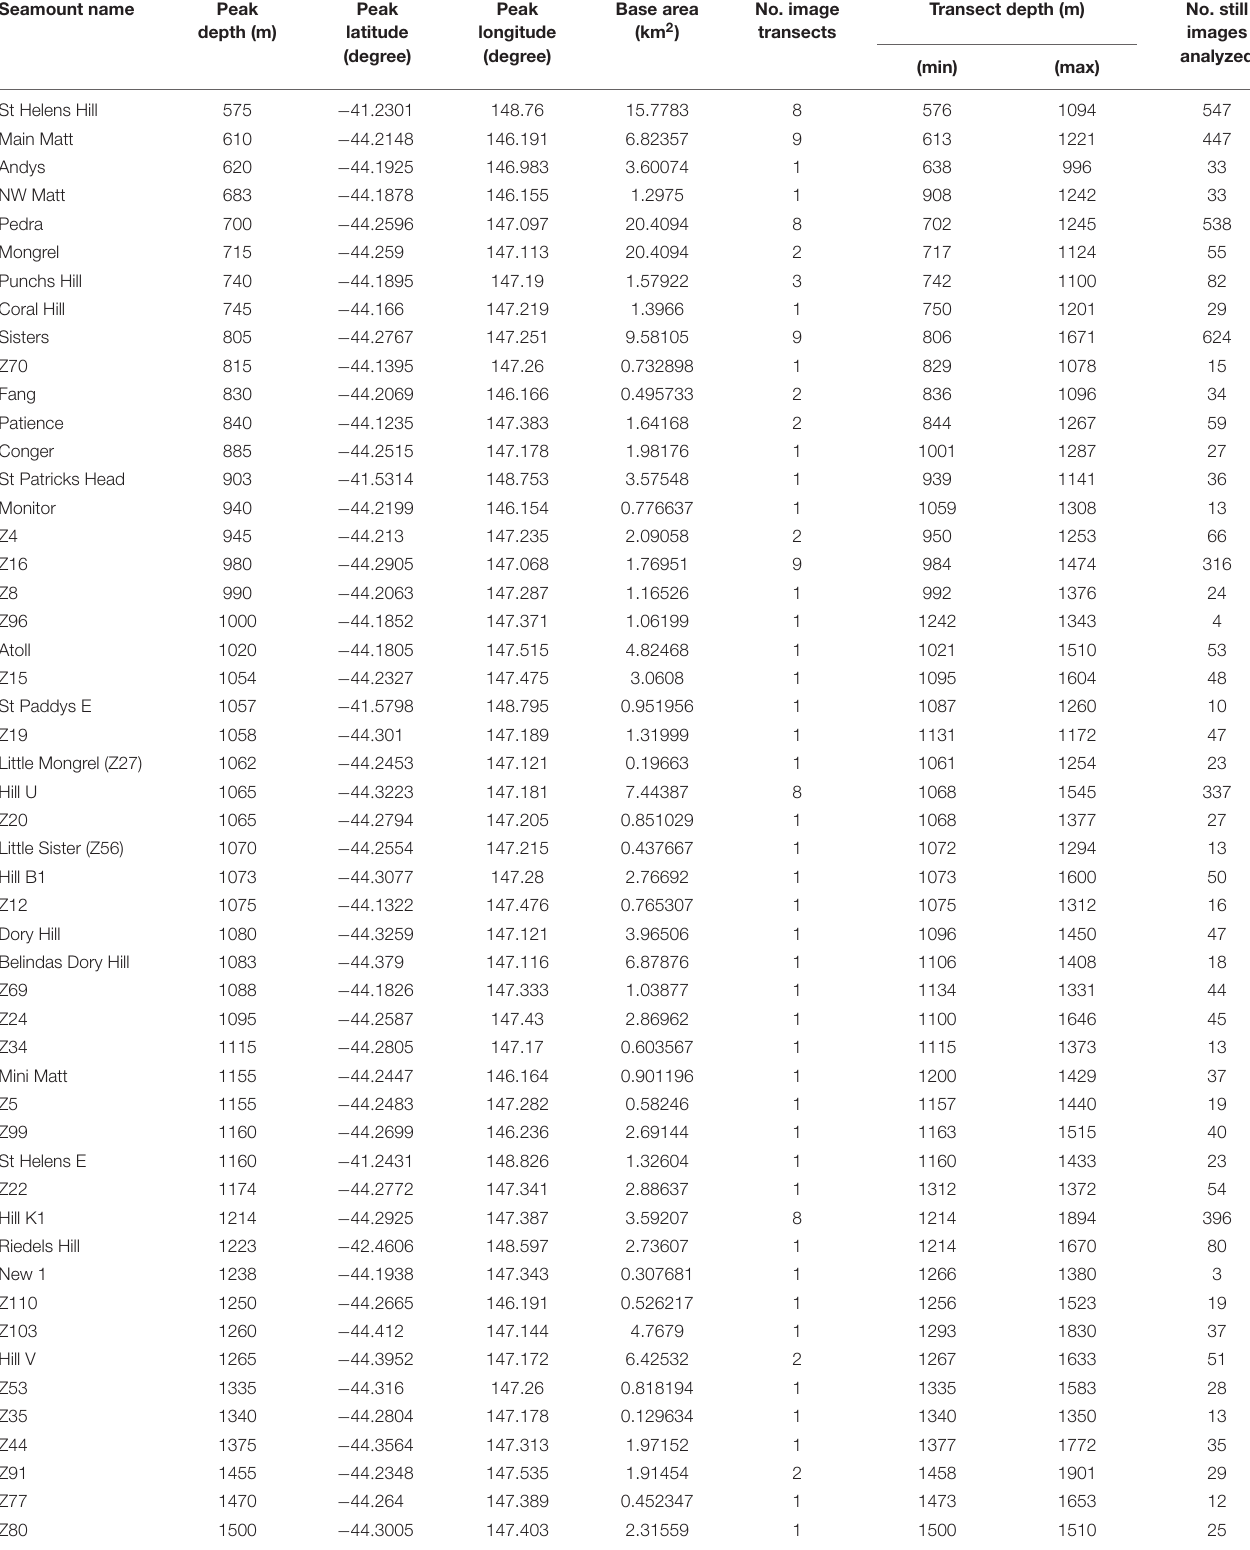
TABLE 1 | The seamounts sampled using a towed camera system showing details of the seamount, the number of camera transects taken and the number of still images analysed. Seamount